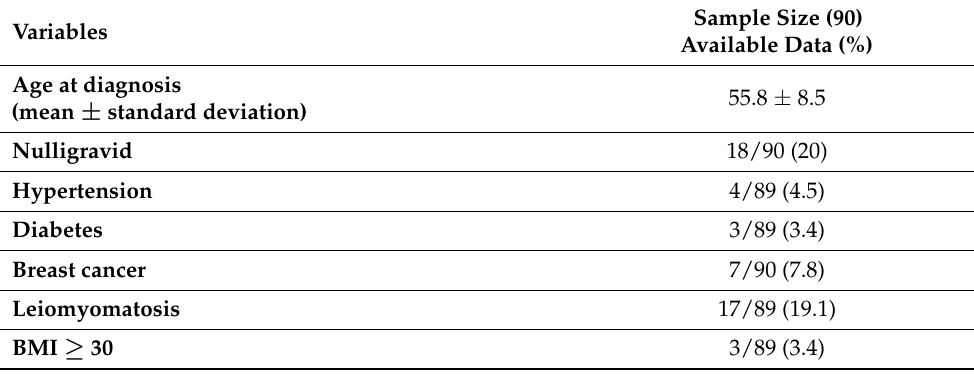
Table 1. Patient